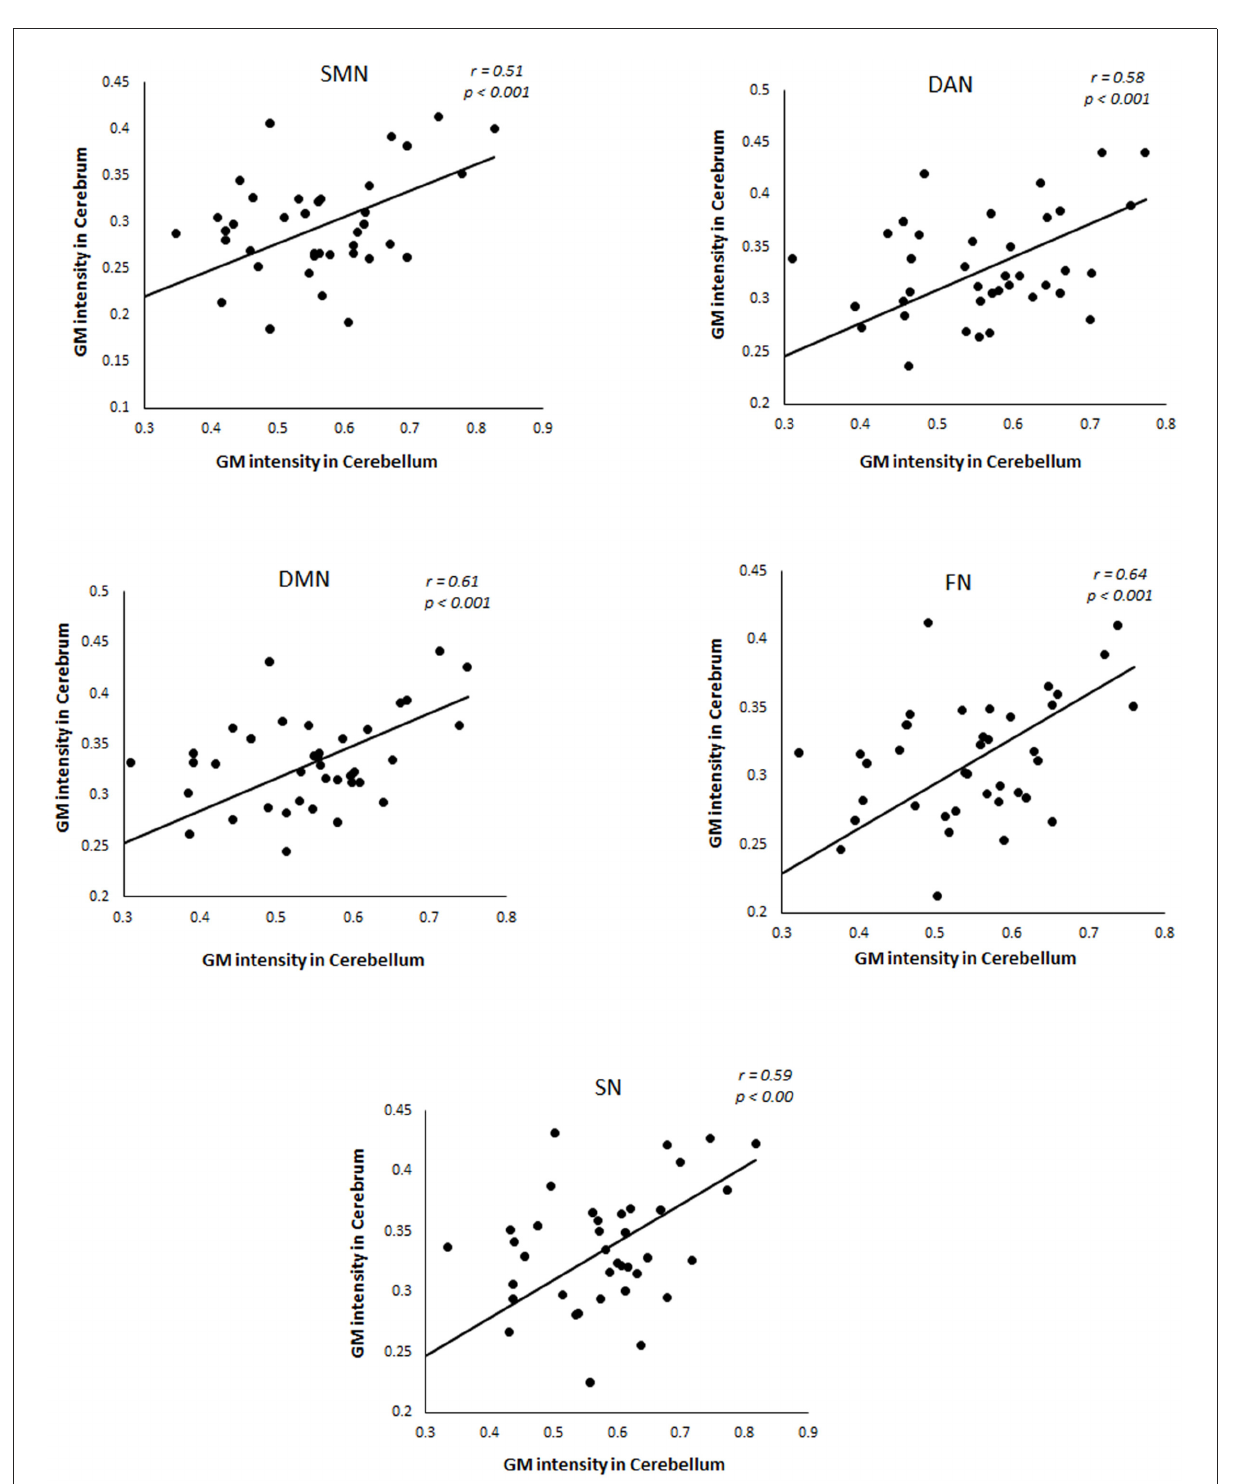
FIGURE2 Relationship between GM intensity in cerebral networks and its cerebellar counterparts in svMCI patients. SMN, Somatomotor Network; DAN, Dorsal Attention Network; DMN, Default Network; FN, Frontal Network; SN, Salience